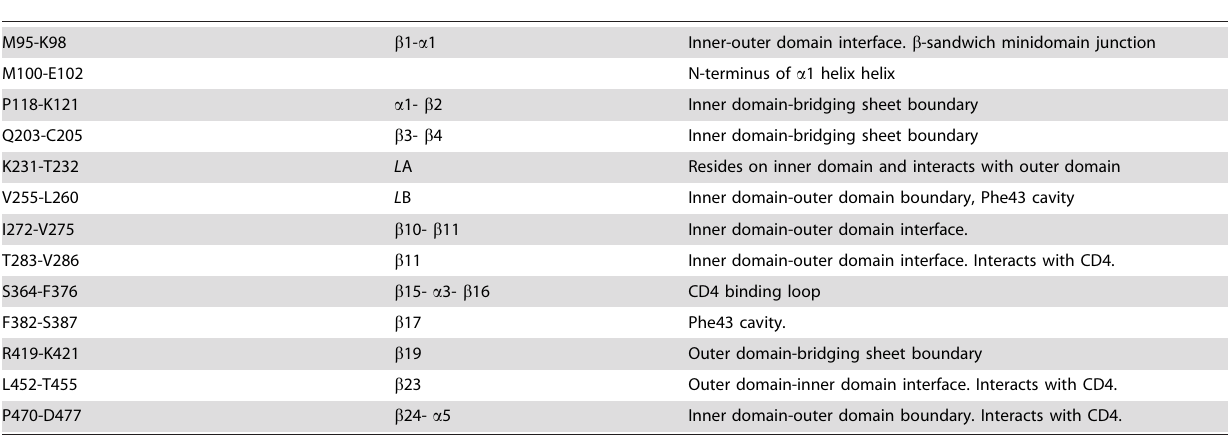
Table 1. Hinge sites of gp120 based on gp120 ternary complex ENM calculation.